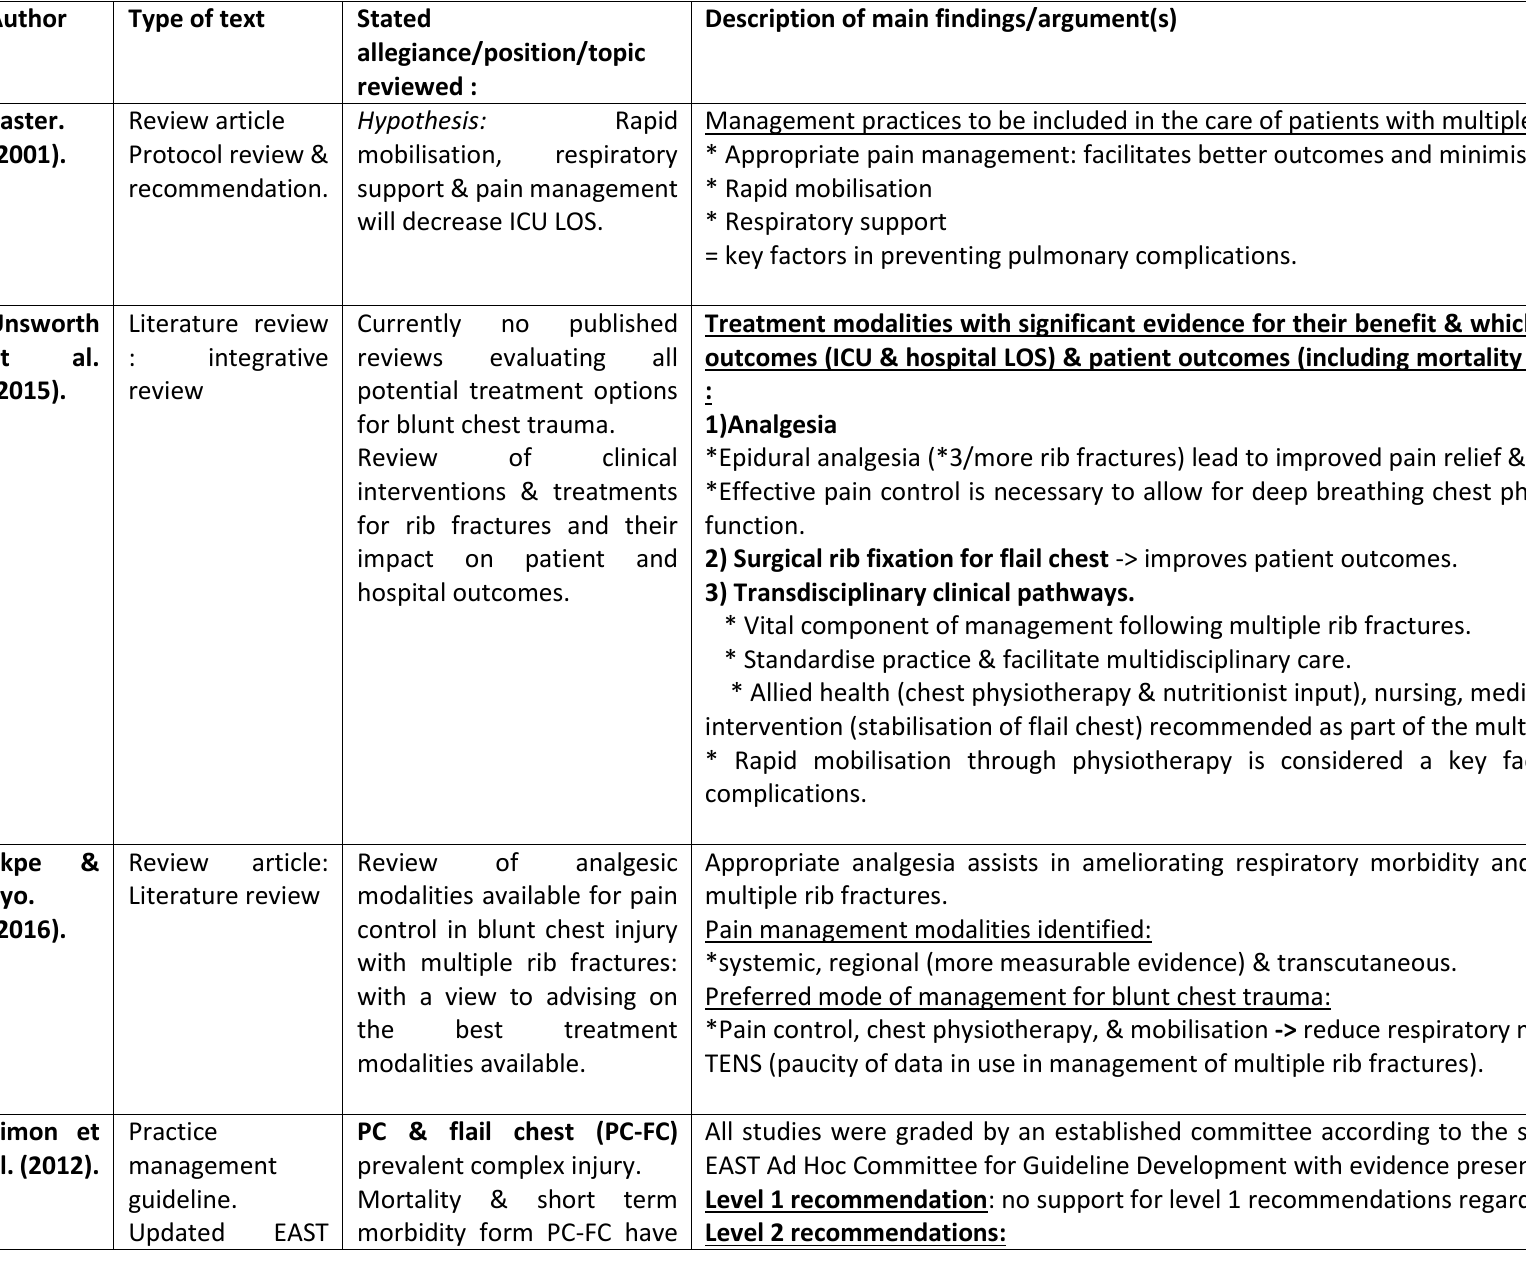
TABLE 15-A1: Findings and conclusions of Included Text and Opinion